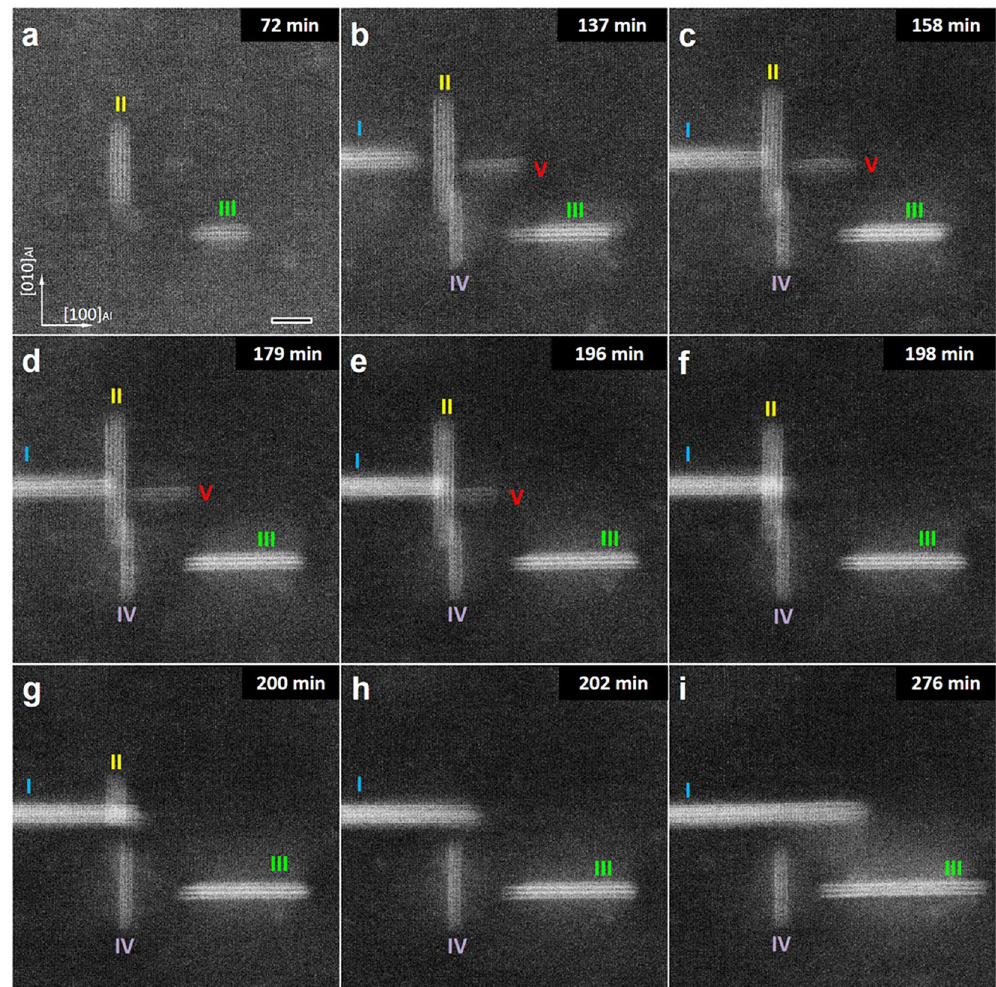
Figure 3. The interaction of precipitates in close proximity to each other. Snapshots taken from HR-STEM Movie S5, showing the features of precipitate morphology at various moments during the heat-treatment of the Al-Cu alloy at 160 °C. It is evident that precipitate I grows further and faster after coming in contact with precipitates II and V, by absorbing them. Scale bars are 5 nm in all